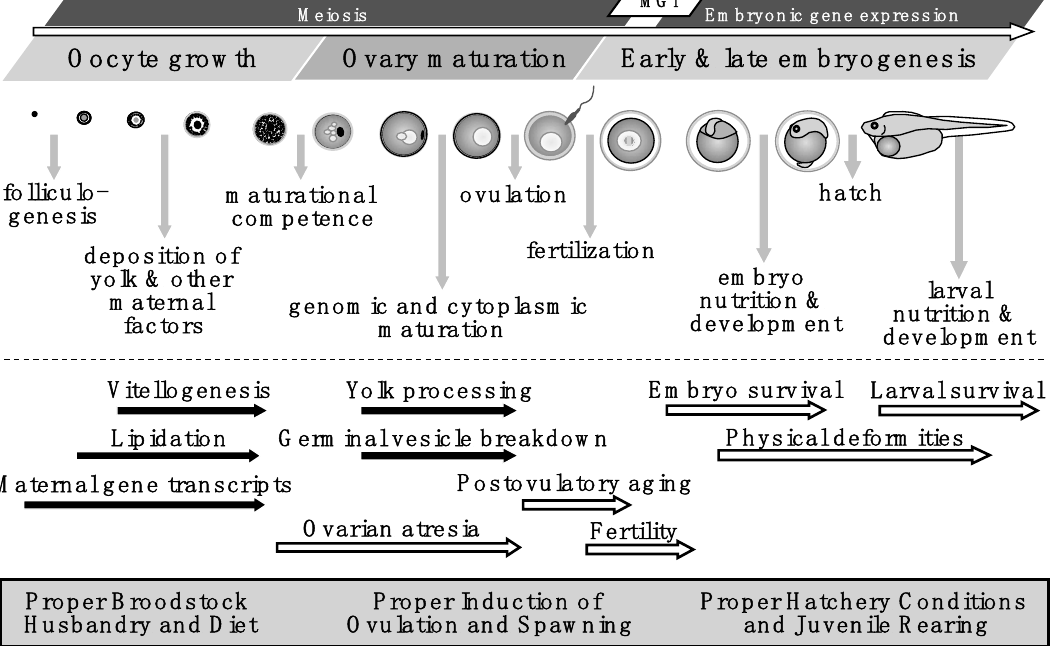
Figure 1. Model depicting the summary of processes and events during oocyte growth, ovary maturation, and early and late embryogenesis in fishes. Vertical grey arrows indicate critical physiological events, horizontal black arrows indicate important processes, and open arrows indicate potential problems or evaluations of egg quality. These topics are detailed in corresponding sections of this review and the figure has been compiled from several studies including those on: folliculogenesis, vitellogenesis, lipidation, and yolk processing [5–41]; maternal gene transcripts [2–4,42–51]; maturational competence, germinal vesicle breakdown, cytoplasmic maturation, and ovulation [15,25,26,30,31,35,52–57]; ovarian atresia (including broodstock stress) [48,52,58–70]; postovulatory aging [48,71–85]; and methods of evaluating egg quality including fertility, embryo survival, larval survival, and incidence of physical deformities [3,42,43,45–51,86]. Proper broodstock husbandry and diet, conditioning for spawning, ovulation, fertilization, and hatchery conditions are required to produce high quality eggs, see also: [1,3,15,25,52,53,58,87–131]. MGT = translation of maternal gene transcripts.